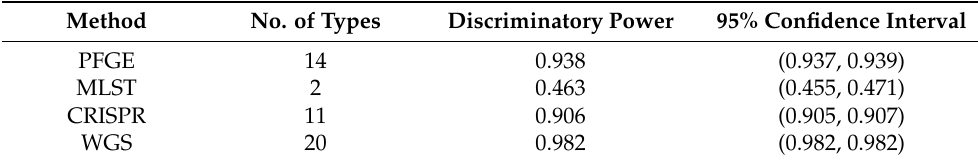
Table 2. Comparison of different subtyping methods for S. enterica serovar Schwarzengrund